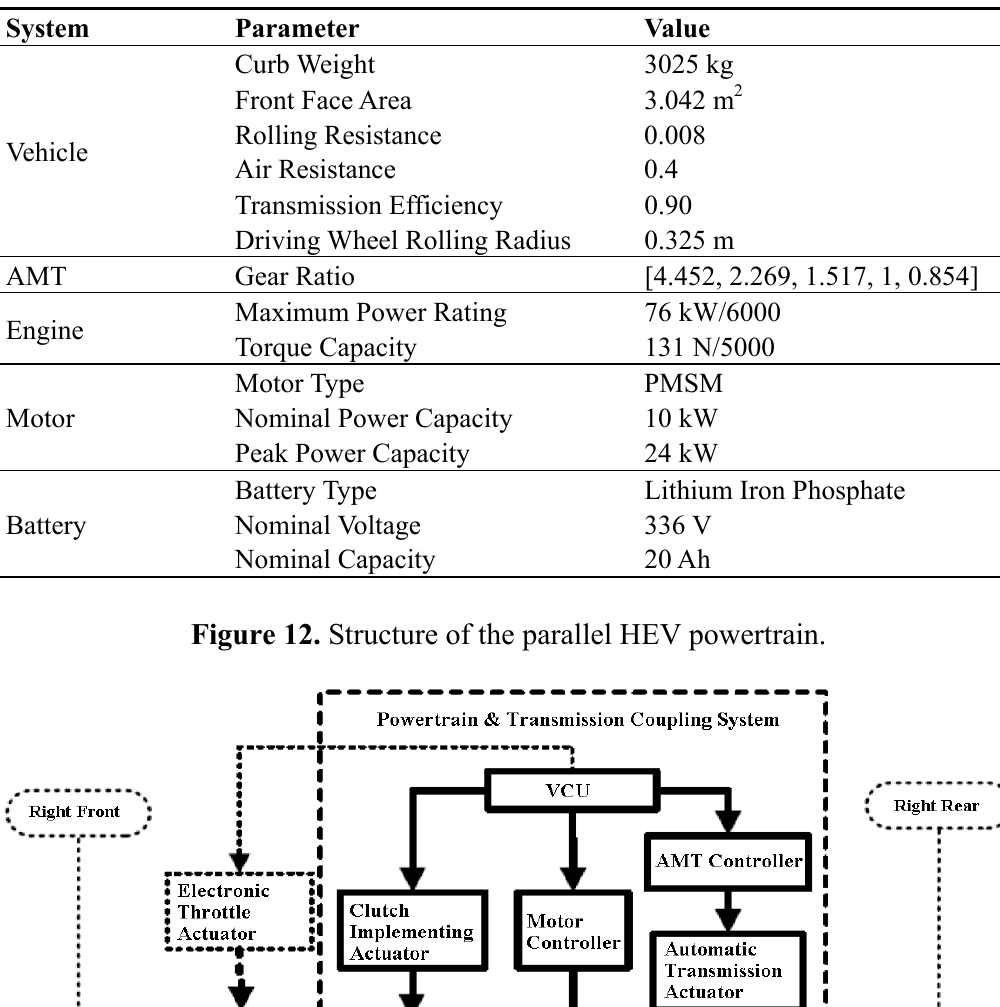
Table 4. Main technical parameters of the parallel HEV powertrain.